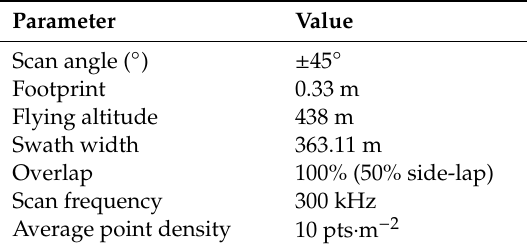
Table 2. Airborne Light Detection and Ranging (LiDAR) survey